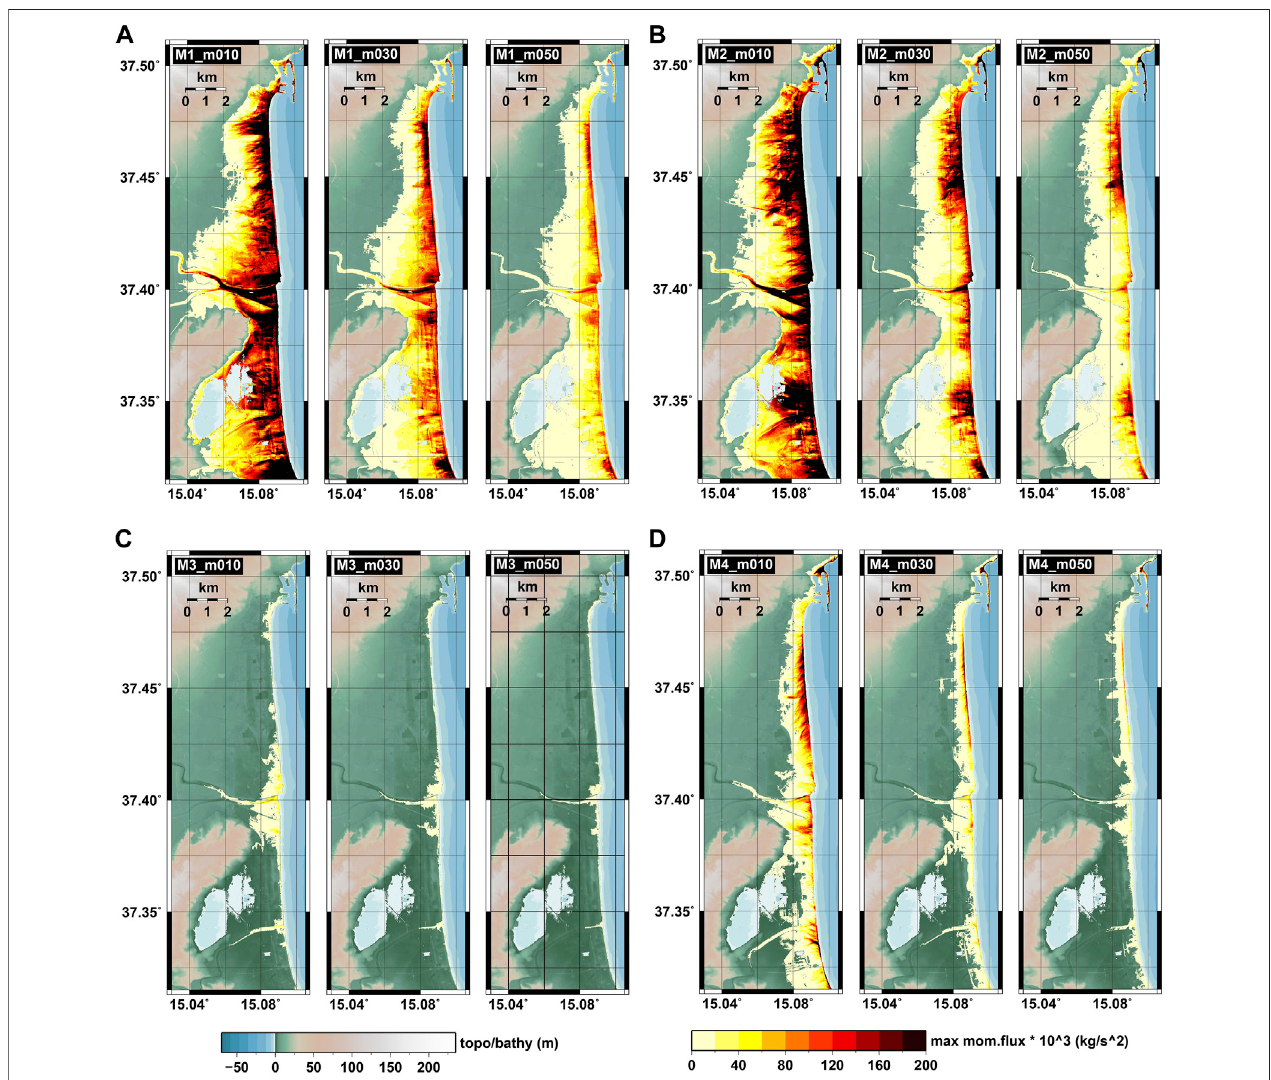
FIGURE 5 | Maximum momentum fl ux recorded as a function of position in the Bay of Catania for earthquake scenarios M1, M2, M3, and M4 in panels (A – D) respectively. Each panel shows the results of the simulations with Manning friction values 0.01, 0.03, and 0.05 as indicated.